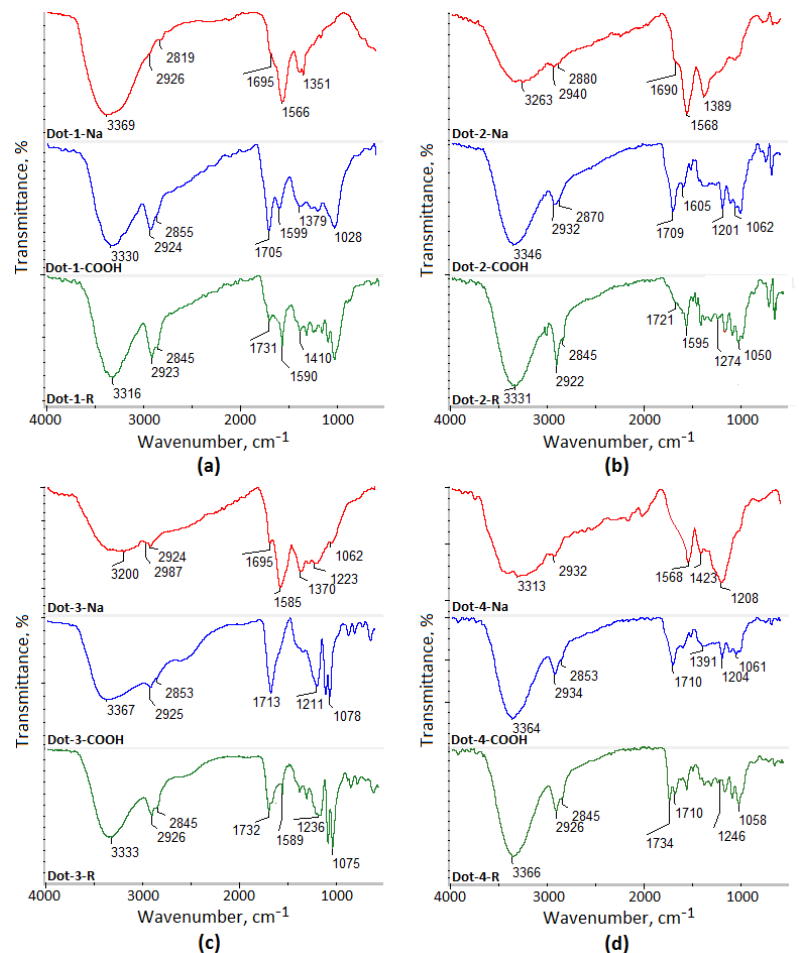
Figure 3. FTIR spectra of the raw CQDs, CQDs with free carboxyl groups and modified CQDs ( a ) Dot-1-Na (Dot-1 sample containing sodium ions), Dot-1-COOH (sample with removed sodium ions and unblocked free carboxylic groups), Dot-1-R (dots modified with Rhod-OH); ( b ) Dot-2-Na (Dot-2 sample containing sodium ions), Dot-2-COOH (sample with removed sodium ions and unblocked free carboxylic groups), Dot-2-R (dots modified with Rhod-OH); ( c ) Dot-1-Na (Dot-3 sample containing sodium ions), Dot-3-COOH (sample with removed sodium ions and unblocked free carboxylic groups), Dot-3-R (dots modified with Rhod-OH); ( d ) Dot-4-Na (Dot-4 sample containing sodium ions), Dot-4-COOH (sample with removed sodium ions and unblocked free carboxylic groups), Dot-4-R (dots modified with Rhod-OH) .